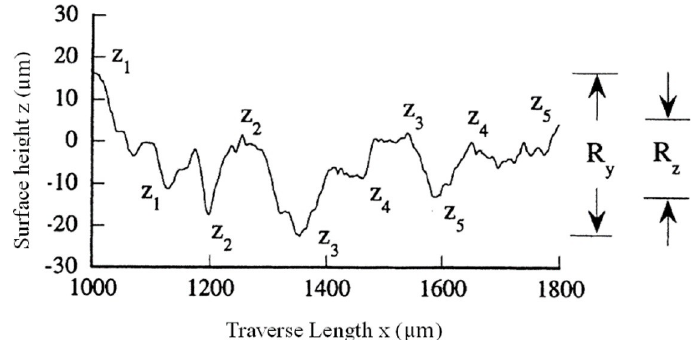
Fig 13. Arbitrary surface profile and standard surface roughness parameters.